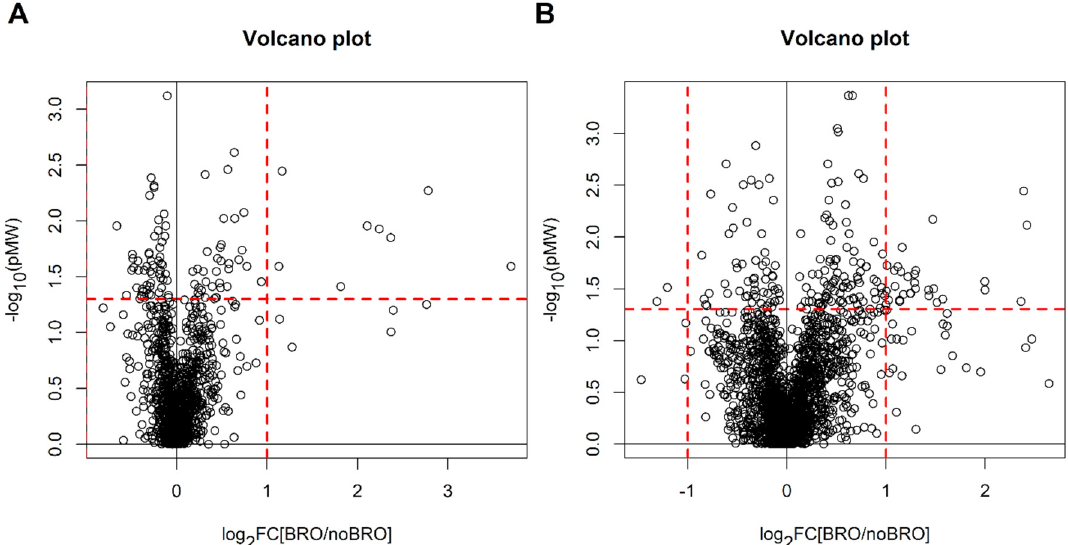
Figure 3. Newborns with bronchiolitis vs. newborns without bronchiolitis: Volcano plots obtained for the POS dataset (panel ( A )) and for the NEG dataset (panel ( B )); the dashed red lines indicate the limits of p Mann-Whitney (pMW) equal to 0.05 and |log 2 FC| = 1.